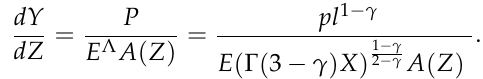
Figure 18. The distribution of the stress Σ ( z ) in the initial space. The final result concerning the stresses in the right initial space is defined reminding that z = 1 − x .